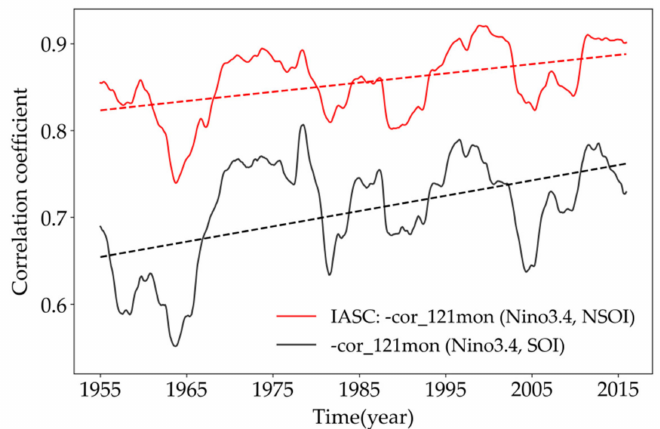
Figure 5. The red solid line shows the change in the Intensity of Air–Sea Coupling (IASC). IASC is defined as the absolute value of the 121-month running correlation coefficient between Niño-3.4 index and NSOI. The black solid line shows the change in the absolute value of the 121-month running correlation coefficient between Niño-3.4 index and SOI. The dashed lines are the corresponding linear trends. All the results pass the Student t -test with a confidence level of